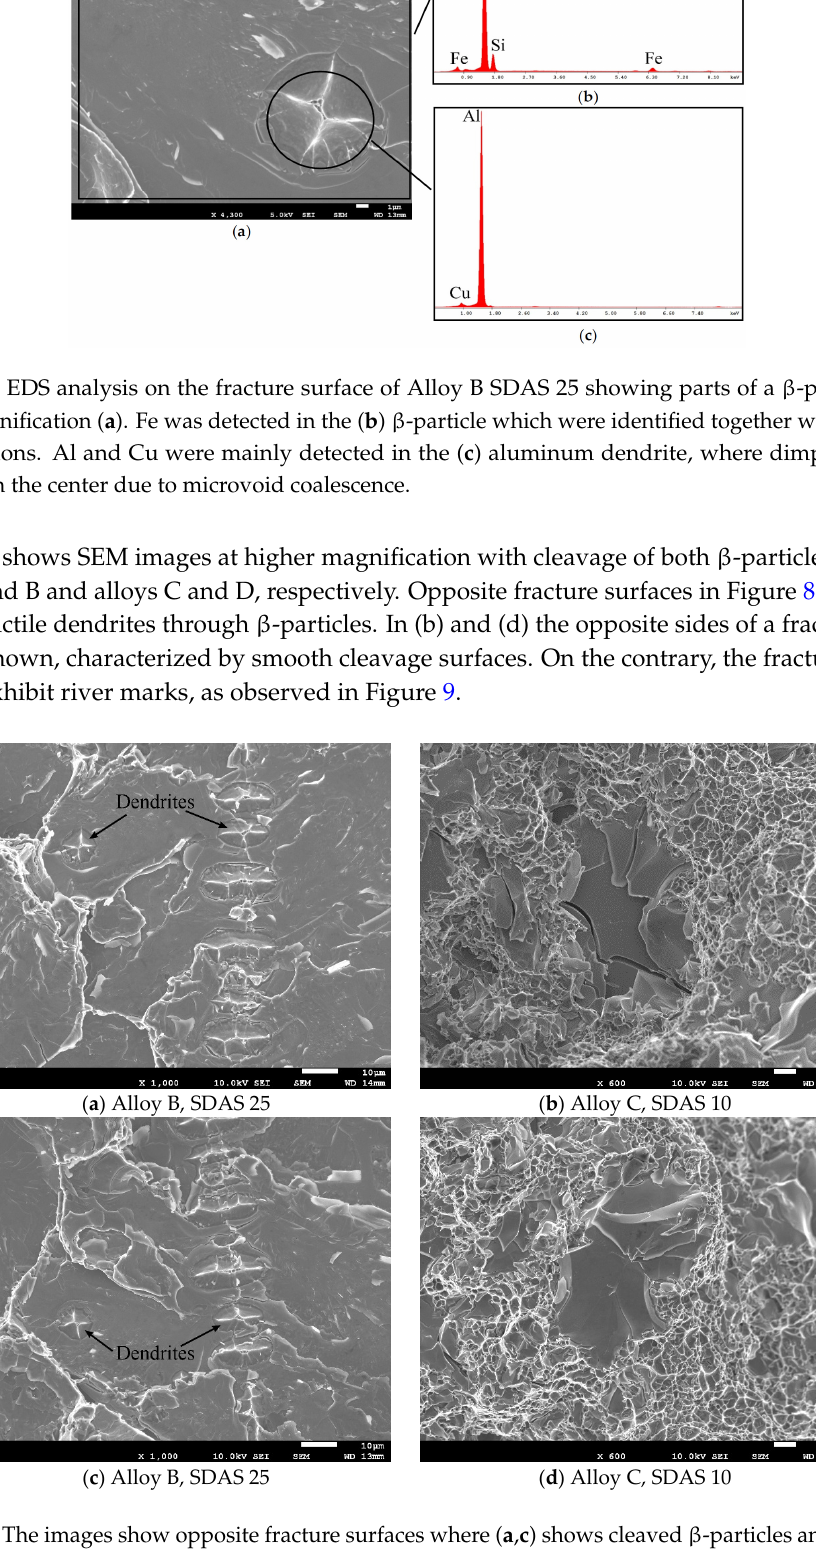
Figure 9. Fracture surface of alloy B SDAS 25 showing a β‐ particle with river marks.